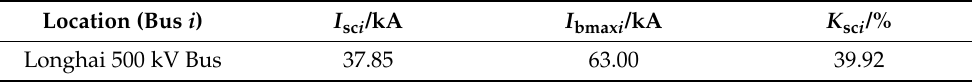
Table 3. The minimum short-circuit current margin in Qujing Power Grid.